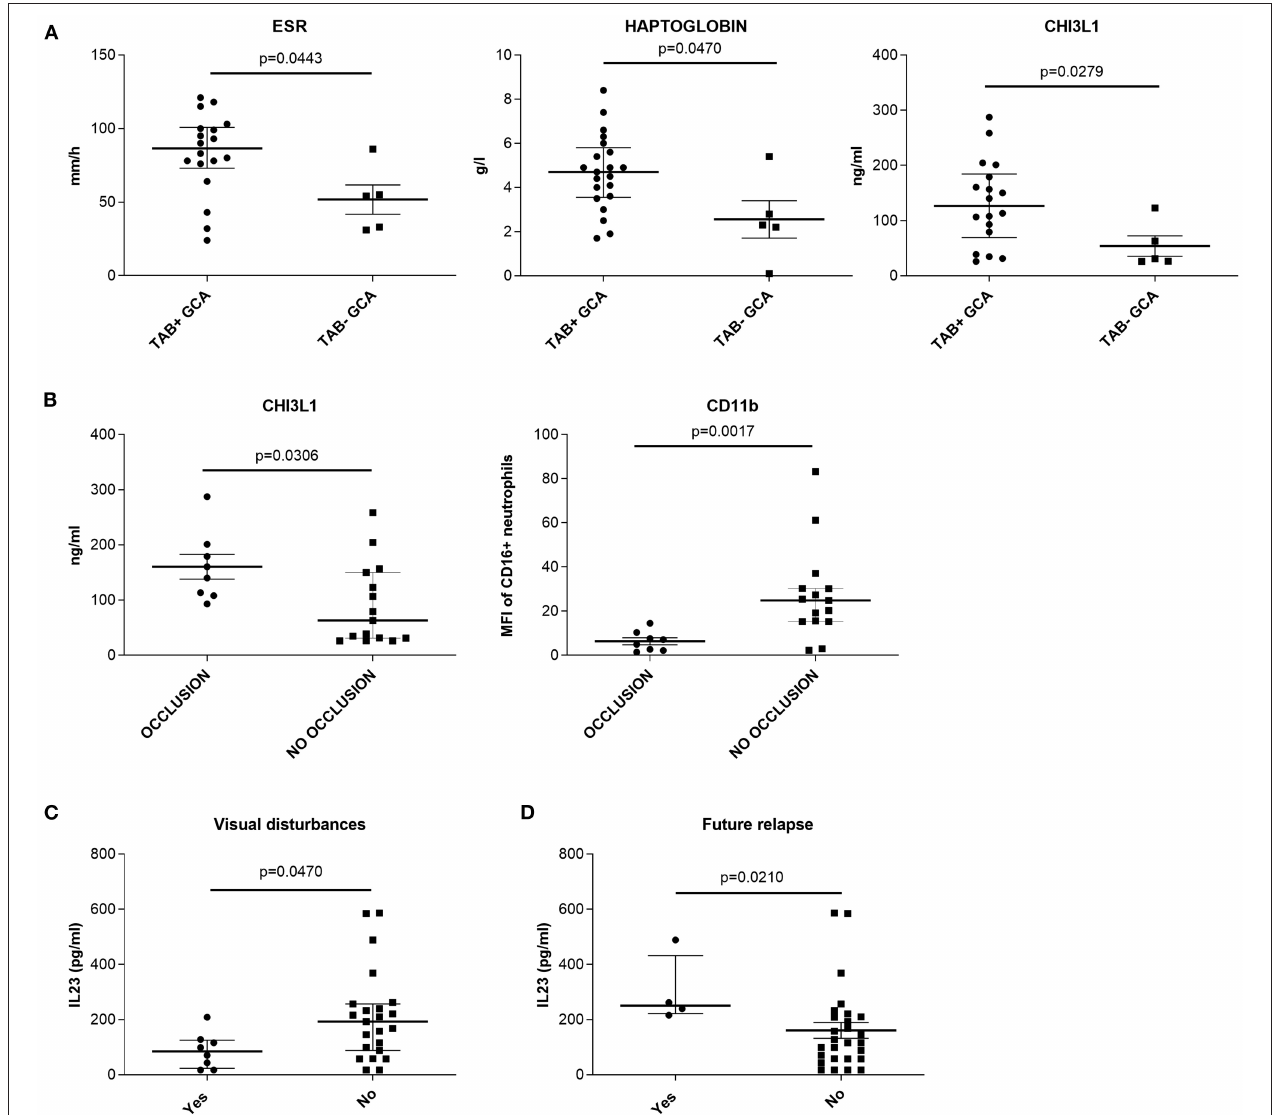
FIGURE 2 | Association between histopathological findings in temporal artery biopsies of therapy-naïve GCA patients and (A,B) presence of visual disturbances; (C) development of a future relapse and (D) measured cell and serum parameters. (A) medians, Q 25 and Q 75 in patients with (TAB + GCA) or without (TAB − GCA) signs of transmural inflammation in the temporal arteries. (B) medians, Q 25 and Q 75 in patients with or without occlusion of the temporal arteries. (C) medians, Q 25 and Q 75 in patients with or without visual disturbances. (D) medians, Q 25 and Q 75 in patients with or without future relapse. CHI3L1, chitinase 3 like protein 1; ESR,